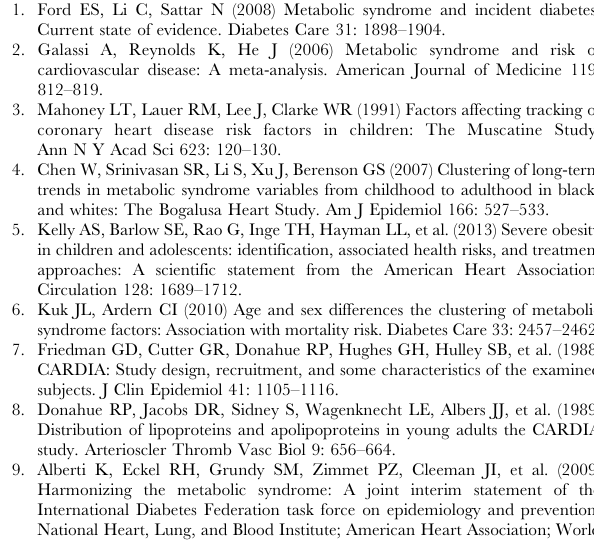
Table S1 Bayesian Information Criterion (BIC) Model